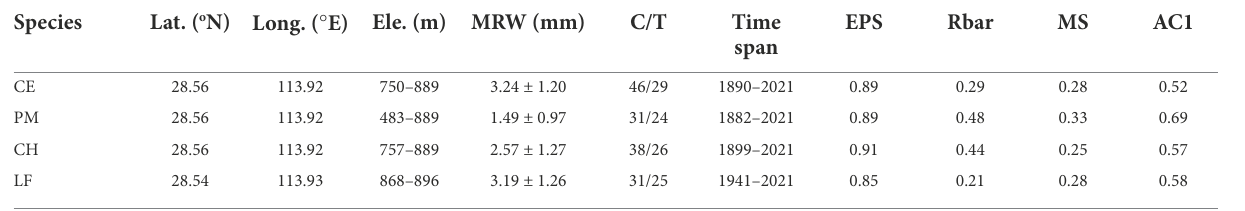
TABLE 1 Information of the sampling sites.